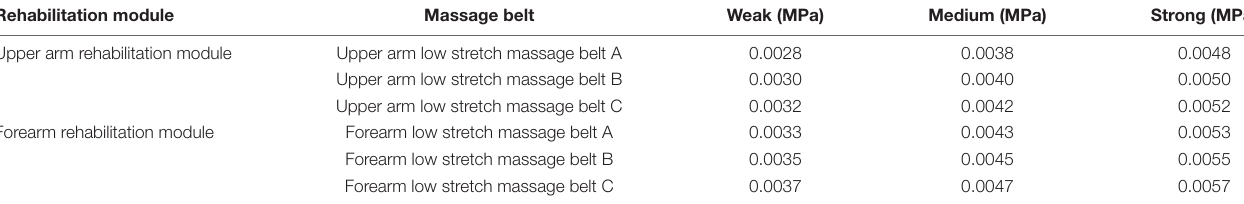
TABLE 7 | Set value of working mode of the massage belt in each rehabilitation module. Rehabilitation module Massage